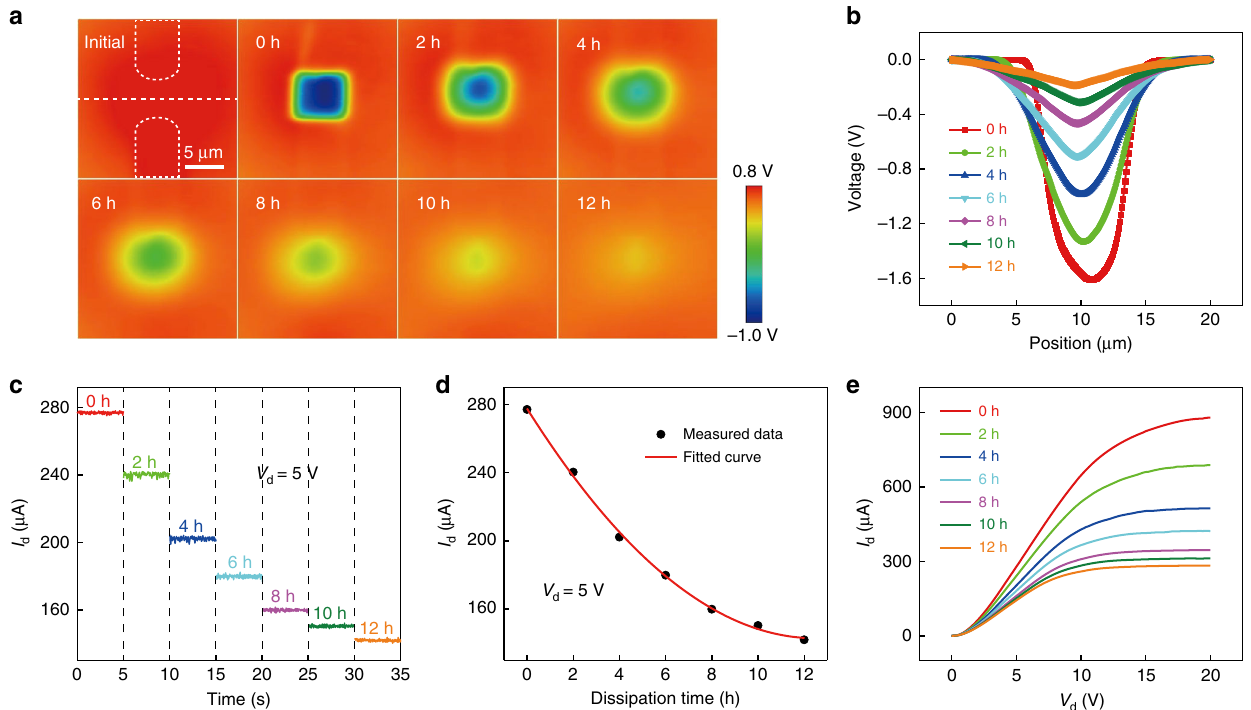
Fig. 4 The effect of charge diffusion on the characteristics of the NTT. a Surface potential distributions of the NTT after regionally rubbed by the AFM tip with increasing dissipation time. b Corresponding potential distributions in cross-sectional view with increasing dissipation time. c I d output characterisics at a drain voltage of 5 V with different dissipation times from 0 to 12 h. d The I d – t transfer characteristics. e I d – V d output characteristics with different dissipation times.